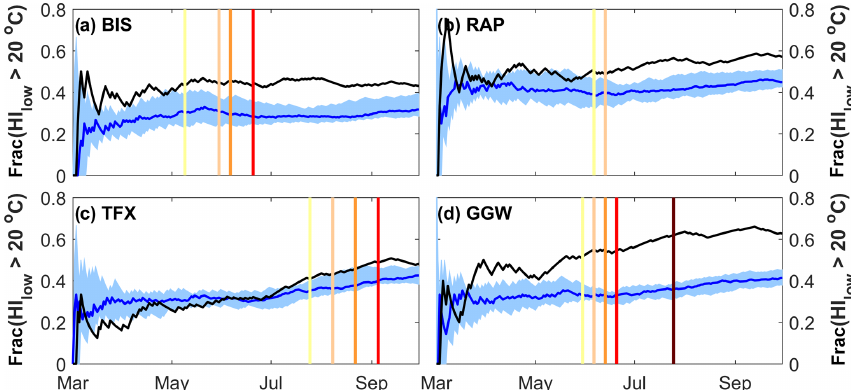
Figure 4. Cumulative fraction of days from March 1 (DOY = 60) to 30 September with the lower troposphere humidity index HI low exceed- ing 20 ◦ C – taken to be the value above which convective precipitation is unlikely – for 2017 (black line) compared to the 30-year median (blue line) and interquartile range (shaded area) for (a) Bismarck, ND; (b) Rapid City, SD; (c) Great Falls, MT; and (d) Glasgow, MT. Vertical lines indicate onset of drought (D0 – yellow to D4 – dark red).